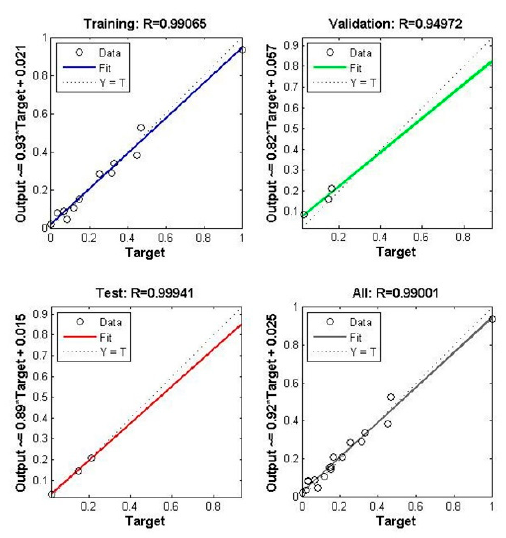
Figure 16. Influence of contact pressure on wear rate.